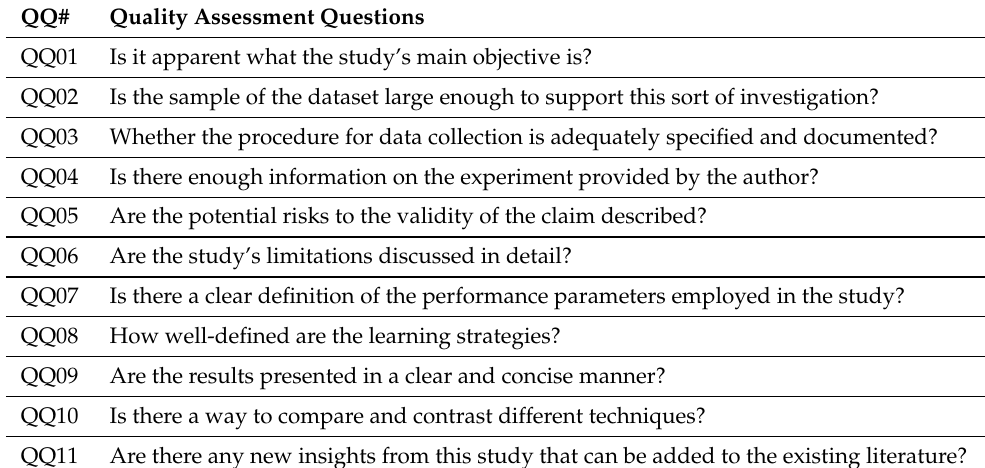
Table 2. Questions for Quality